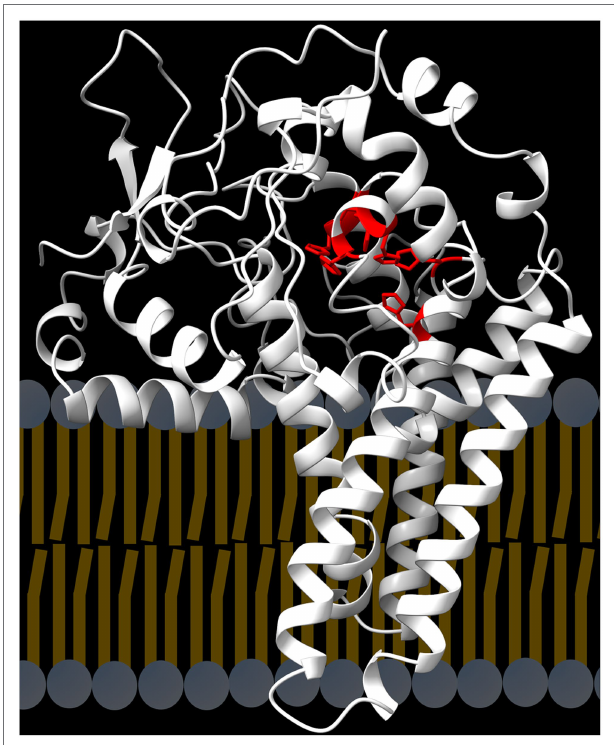
FIGURE 5 | Structure of the FAD2 desaturase. The protein contains four hydrophobic, α− helices that span the enodplasmic reticulum bilayer. In the folded protein the three conserved histidine boxes (red) are brought together to coordinate the diiron-oxo complex at the active